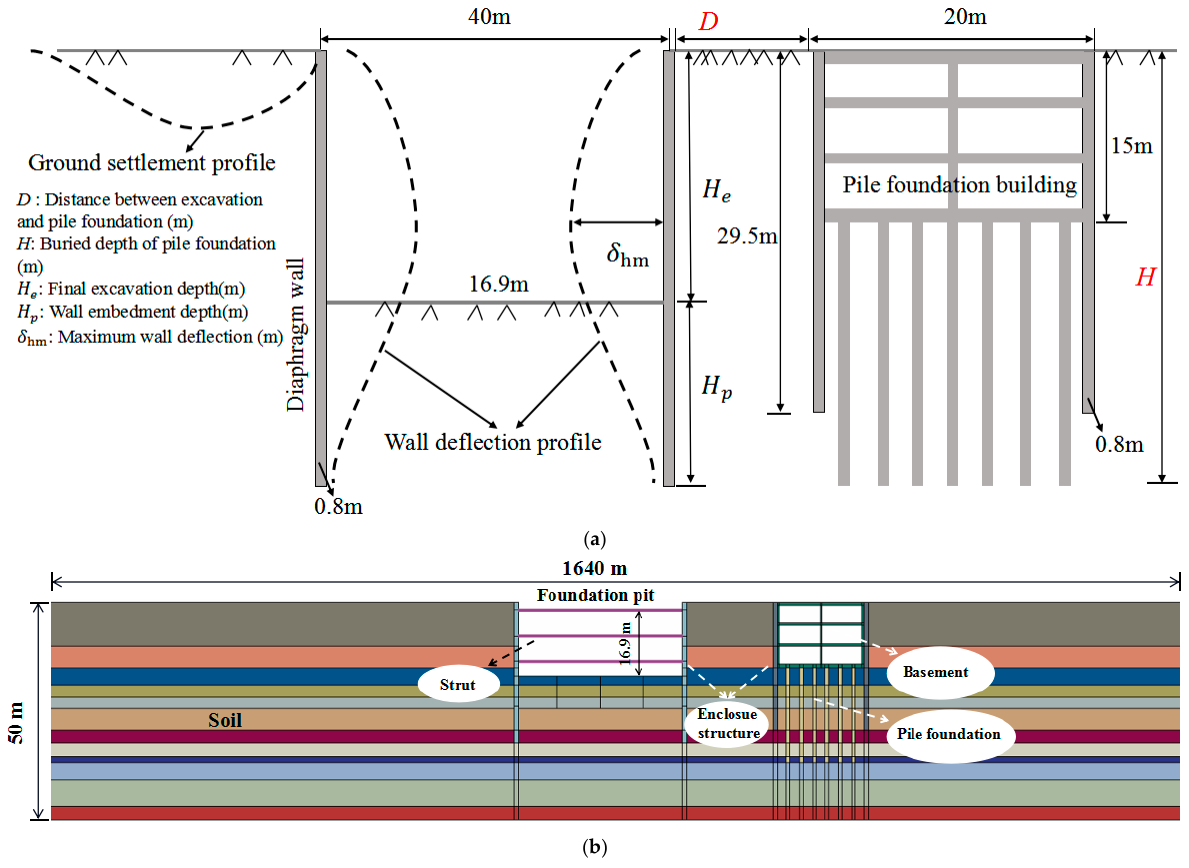
Figure 1. Model of the Project: ( a ) Geometric model; ( b ) Finite element model.